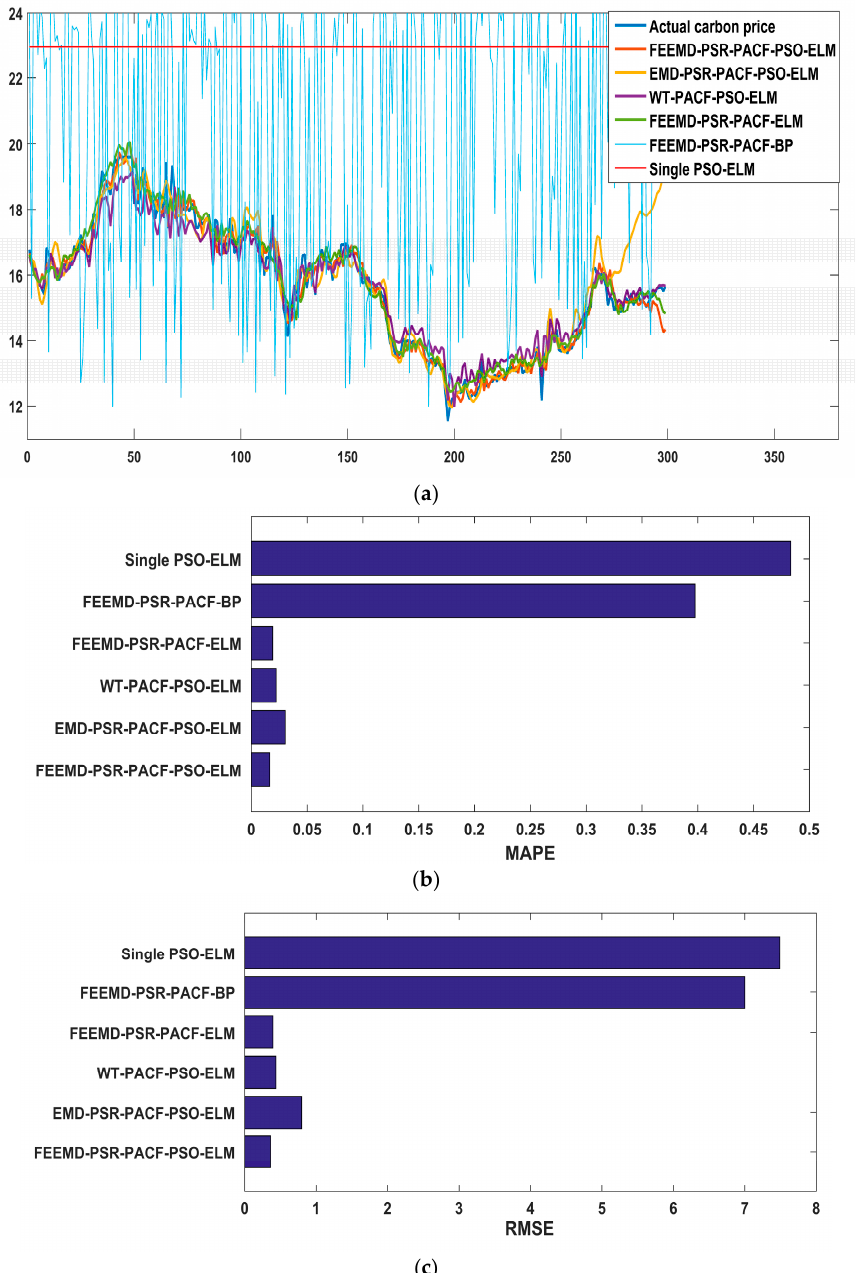
Figure 14. ( a ) The carbon price forecasting curves of Hubei; ( b ) The MAPE values; ( c ) The RMSE values. Table 9. A comparison of the different forecasting models under the Shenzhen ETS and the Hubei ETS.